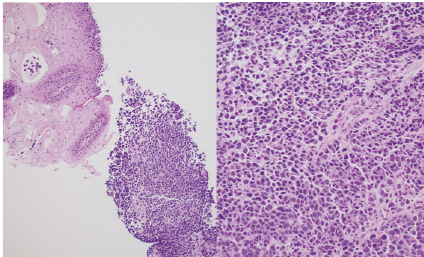
Figure1:H+Estainshowingthetumorcellsreplacingthesquamous mucosa (left side, 10x). Discohesive malignant tumor cells growing in sheets (H&E, right, 20x).